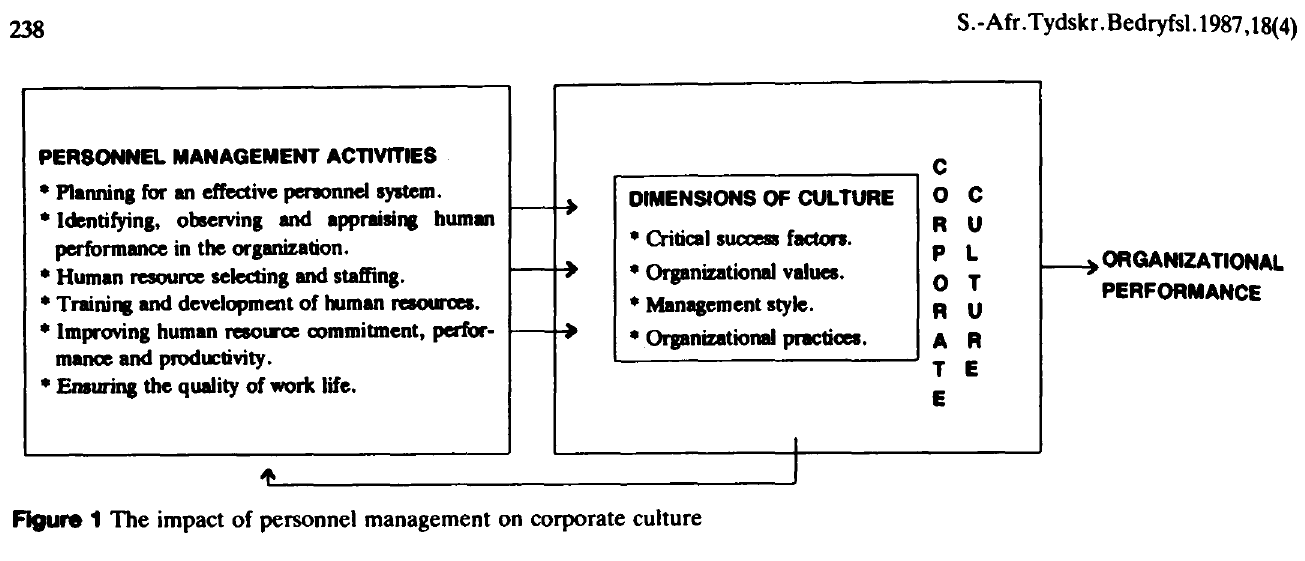
Figure 1 The impact of personnel management on corporate culture development, maintenance or change of an